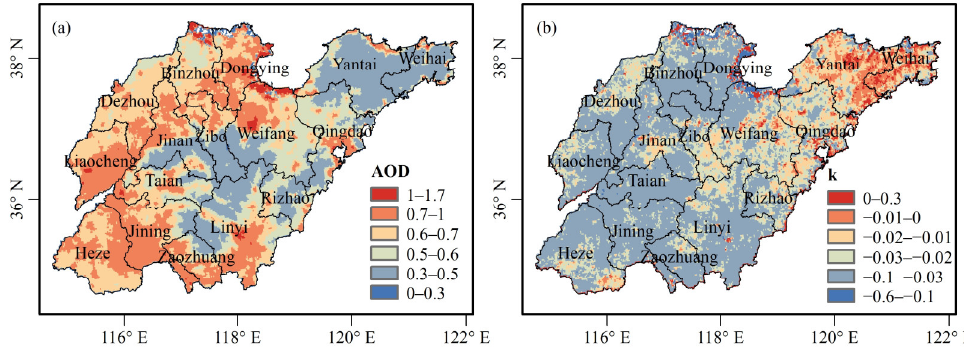
Figure 3. ( a ) Spatial distribution and ( b ) decreasing rate of AOD by prefecture level cities in Shandong Province from 2015 to 2020.